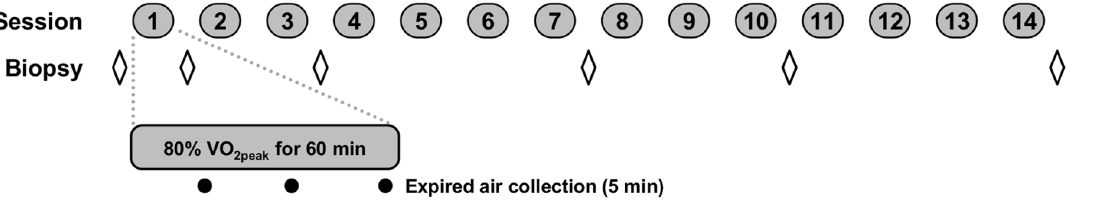
Figure 1. Study design for time course analysis of exercise training-induced changes in skeletal muscle gene expression. Each subject performed fourteen consecutive days of exercise training on a stationary cycle ergometer with one session each day for 60 min at pre- training 80%VO 2peak . Skeletal muscle biopsies were taken at baseline (day 0), and on the morning following the first, third, seventh, tenth and fourteenth training sessions. In order to monitor exercise intensity, oxygen uptake was measured for 5 min at three time points (15–20 min, 35– 40 min and 55–60 min) during each training session.